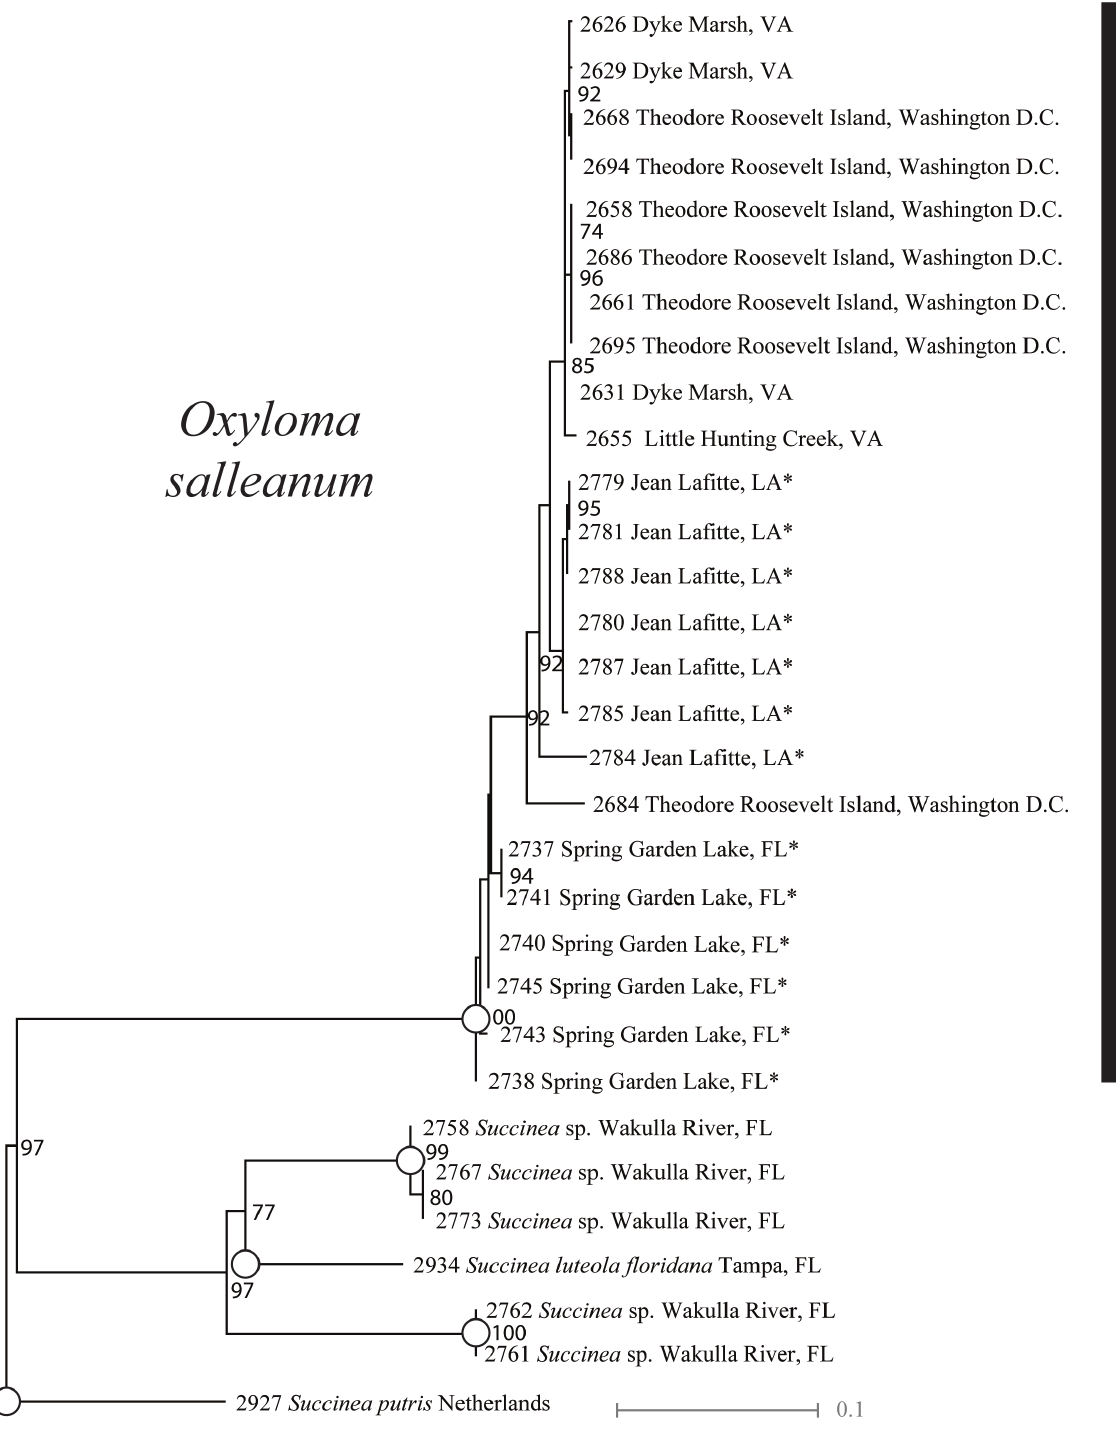
Fig. 2. Maximum likelihood phylogeny from 690 bp alignment of 34 COI sequences presenting only the focal taxa and localities. Ultra-fast bootstrap values indicated behind the nodes supported. Full 142-individual analysis reported in Supp. file 2, Supp. file 3. Type localities indicated with an *. Species supported by species delimitation analyses indicated with a hollow